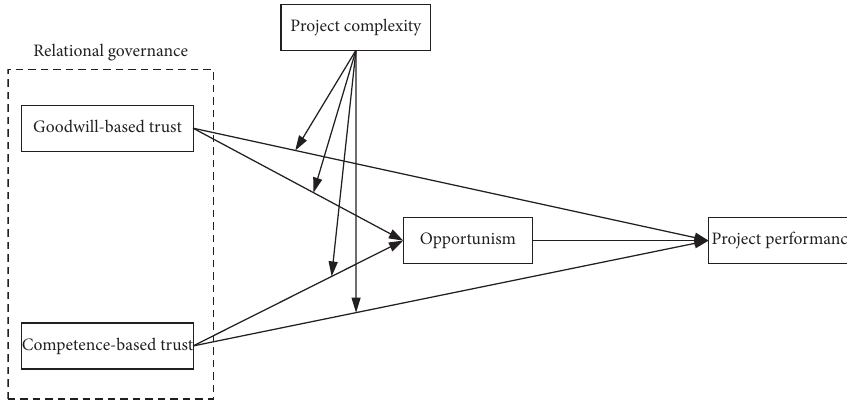
Figure 1: Conceptual framework.